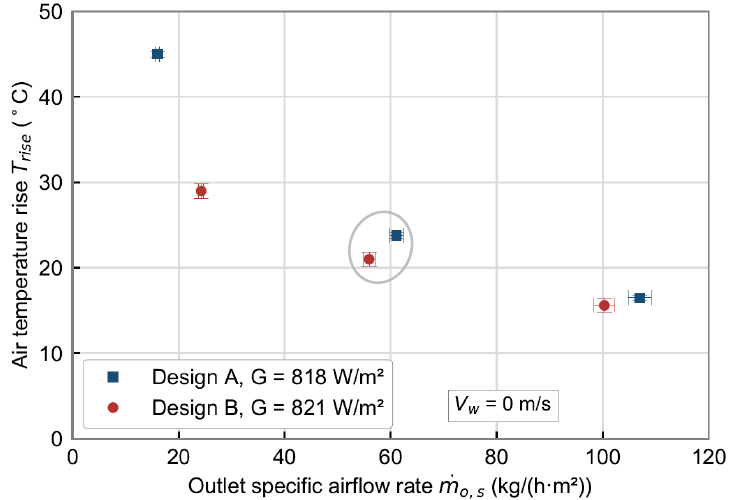
Figure 20. Temperature rise comparison as a function of the outlet specific airflow rate.